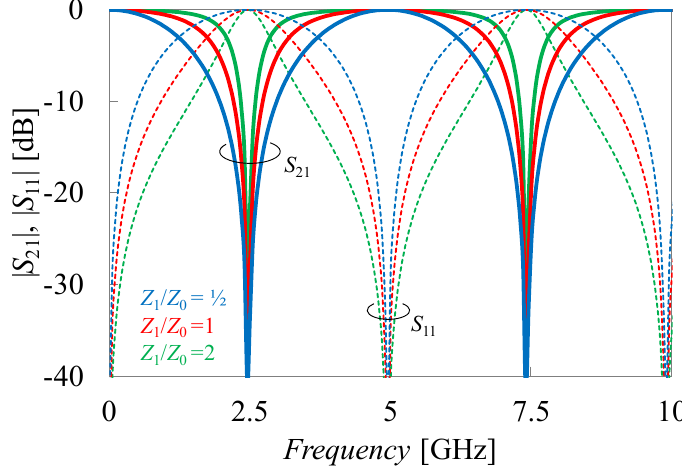
Figure 2. Calculated results of transmission coefficients | S 21 | and reflection coefficients | S 11 | for different characteristic impedance ratios between the stub line and the main transmission line ( Z 1 / Z 0 ). Three patterns show Z 1 / Z 0 = 1/2, 1, and 2. The stop bandwidth widens if Z 1 / Z 0 is smaller. Smaller impedance ratio means that the stub line width W 1 becomes wider.